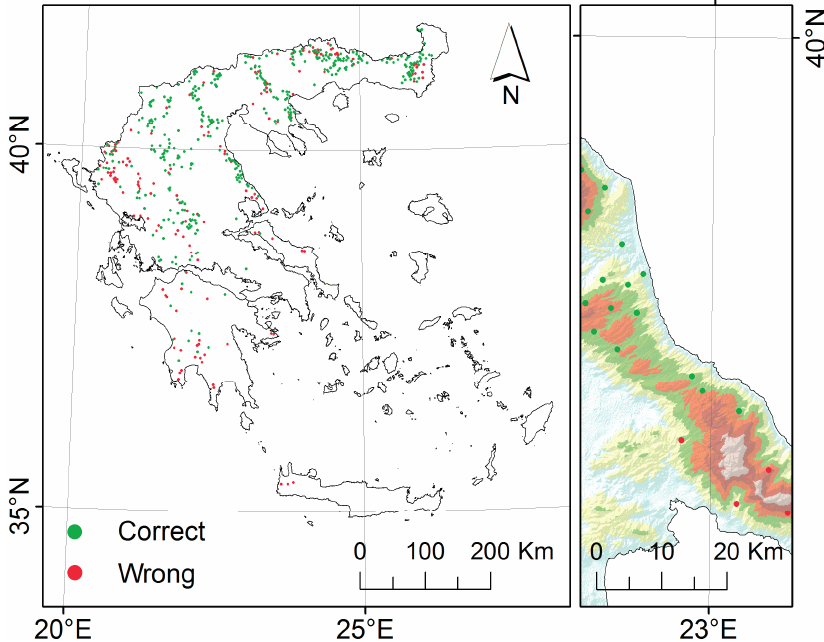
Figure 6. Spatial distribution of classification errors for the class “Broadleaved forests” of WWF Hellas map; in the inset, a closer view from central Greece, on an elevation